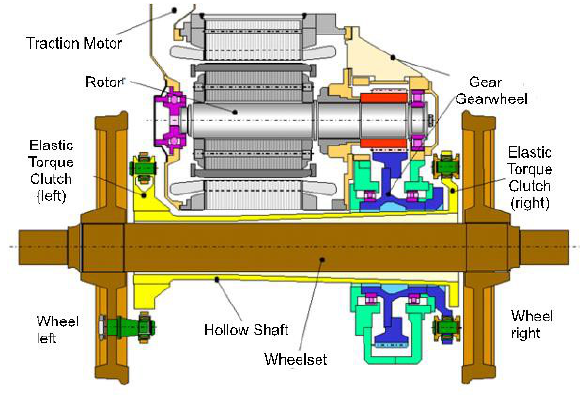
Figure 2. A fully-suspended drive of a locomotive